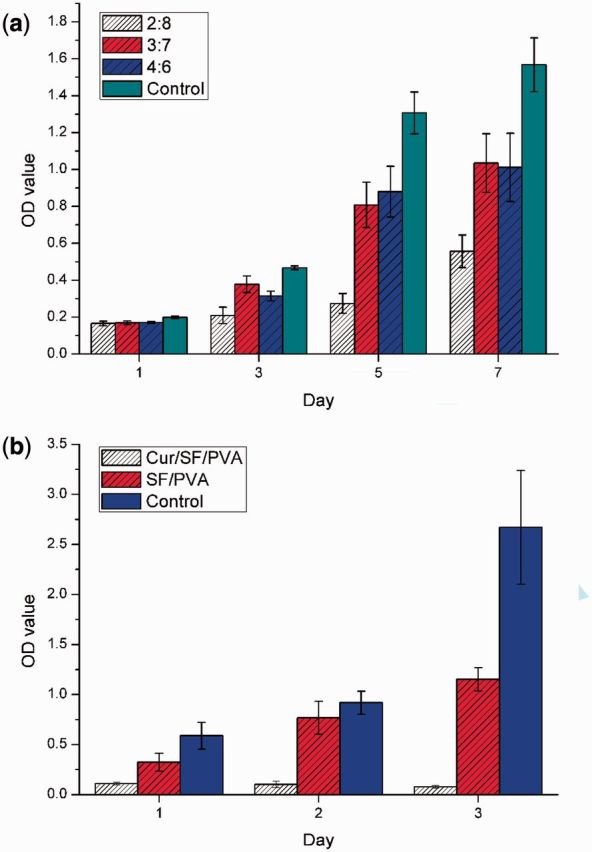
Cell culturing results of 3T3 fibroblasts (a) directly on the SF/PVA blend scaffolds and (b) extraction medium